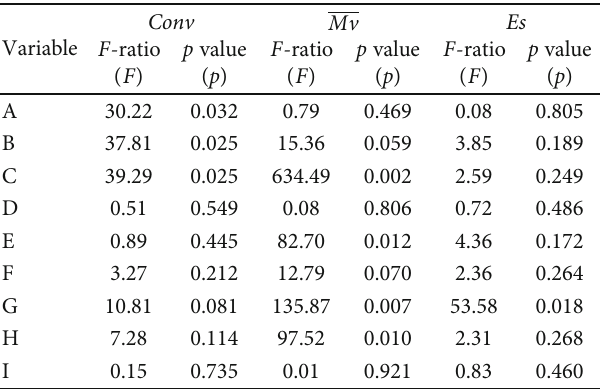
Table 5: ANOVA results for the experimental design used in terpolymerization